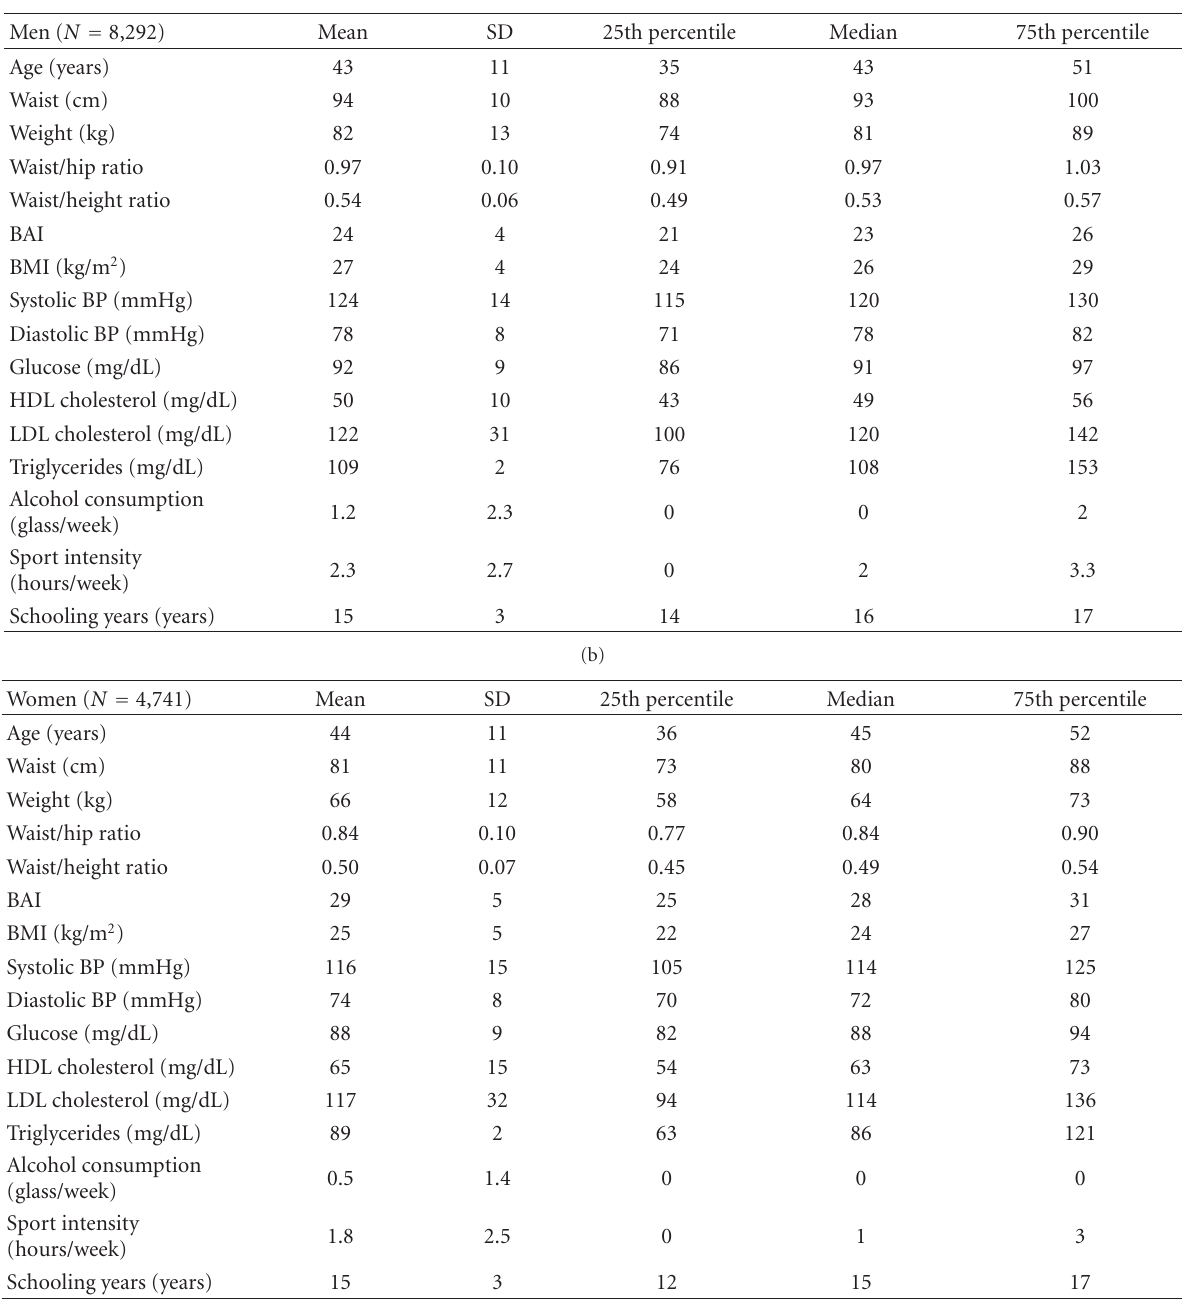
Table 1: Mean, SD and the quartiles of the di ff erent anthropometric and laboratory variables in men (upper part) and women (lower